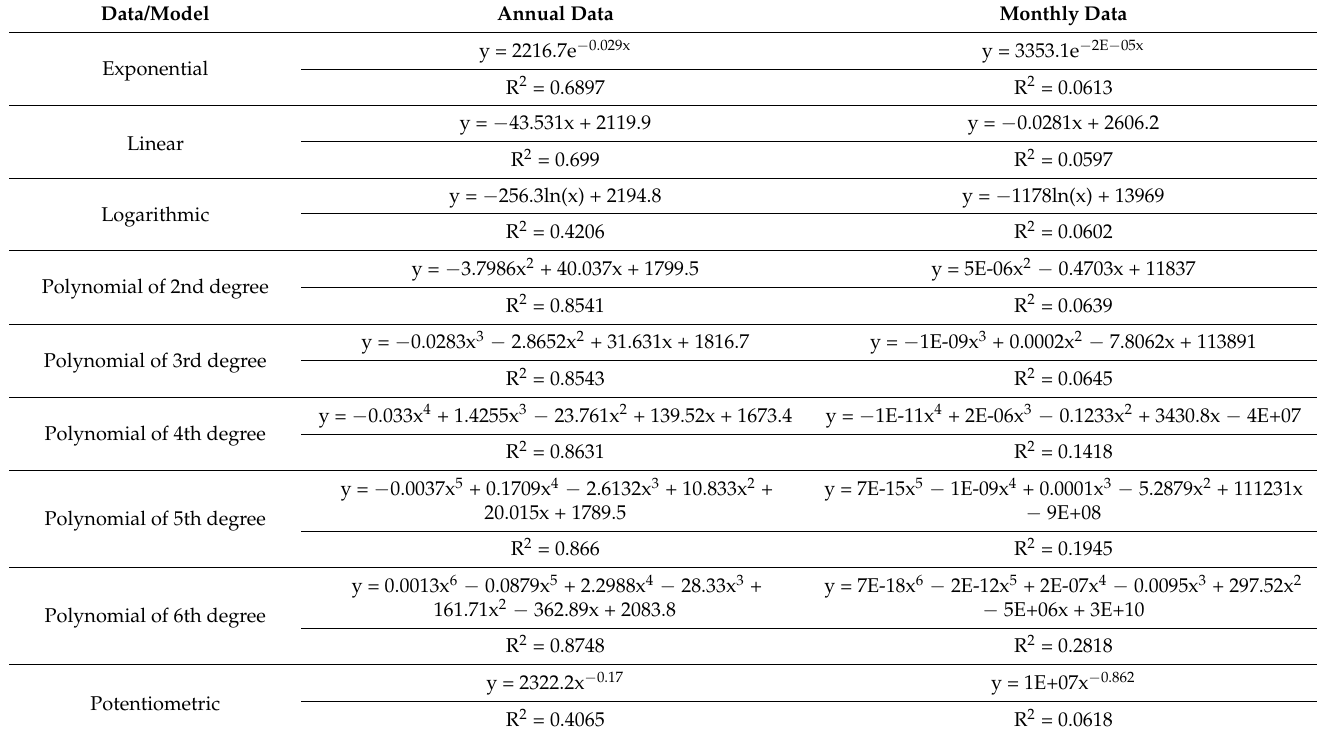
Table A14. Trend models for the Warmian–Masurian province.